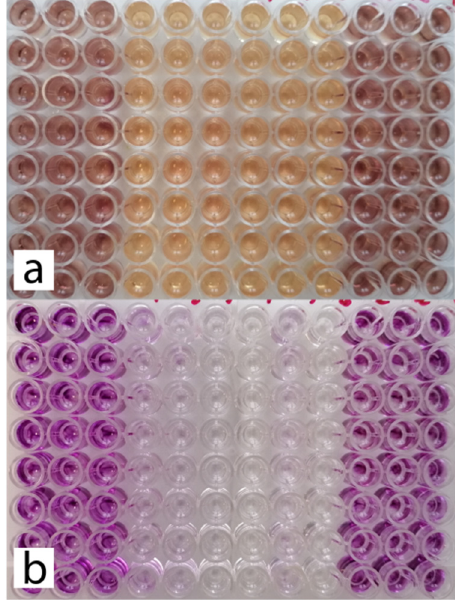
Figure 2. ( a ) Plate with cultures of L-929 cells immediately after a 24 h incubation period with 2-fold diluted extracts of the test preparations. ( b ) MTT assay performed for cultures shown in image ( a ) (after formazan extraction with DMSO).